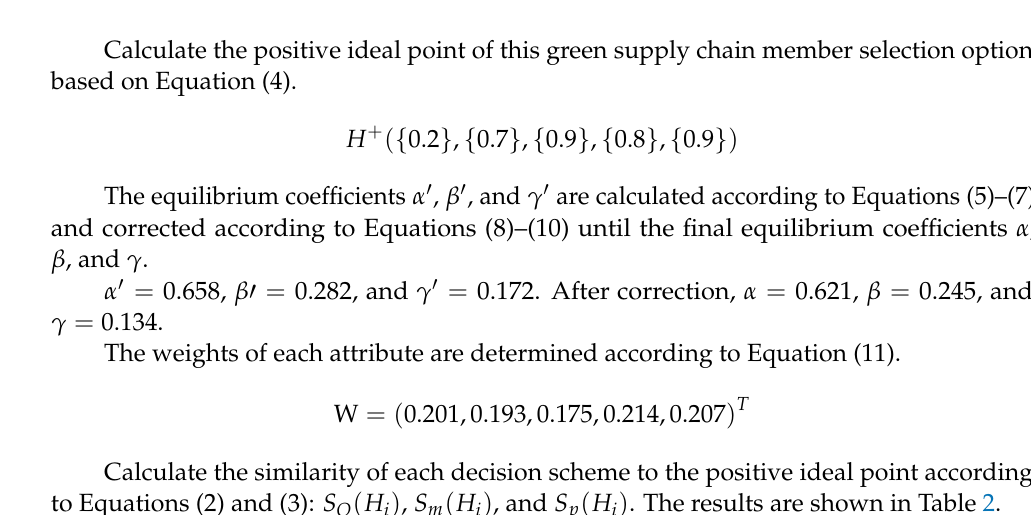
Table 1. Green supplier decision matrix D =